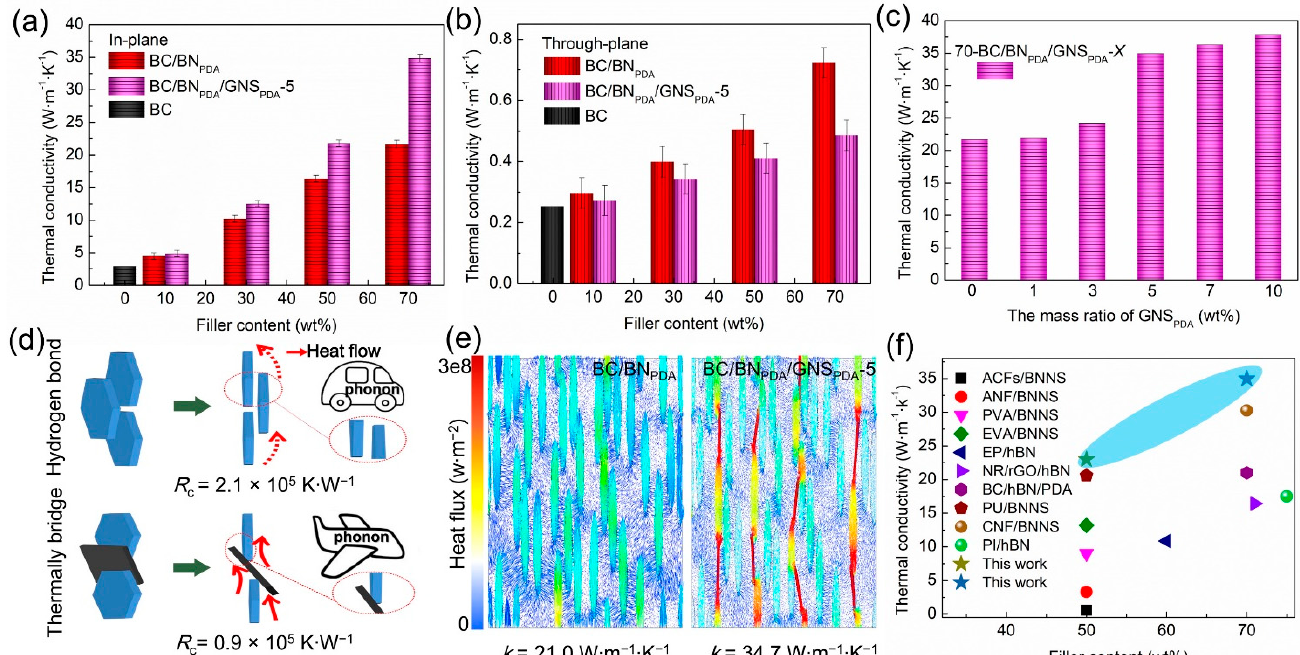
Figure 3. ( a ) In-plane and ( b ) through-plane thermal conductivities of two composite films: BC/BN PDA and BC/BN PDA /GNS PDA -5 at different filler contents. ( c ) In-plane thermal conductivities of the 70 wt% BC/BN PDA /GNS PDA composite films at different mass ratios of GNS PDA . ( d ) Schematic diagram of the effect of contact thermal resistance on phonon transport. ( e ) Numerical simulation of heat transfer behaviors between BC/BN PDA and BC/BN PDA /GNS PDA -5 films in the preferred direction. ( f ) Comparisons of in-plane thermal conductivity of this work with the reported BN-based composites from the